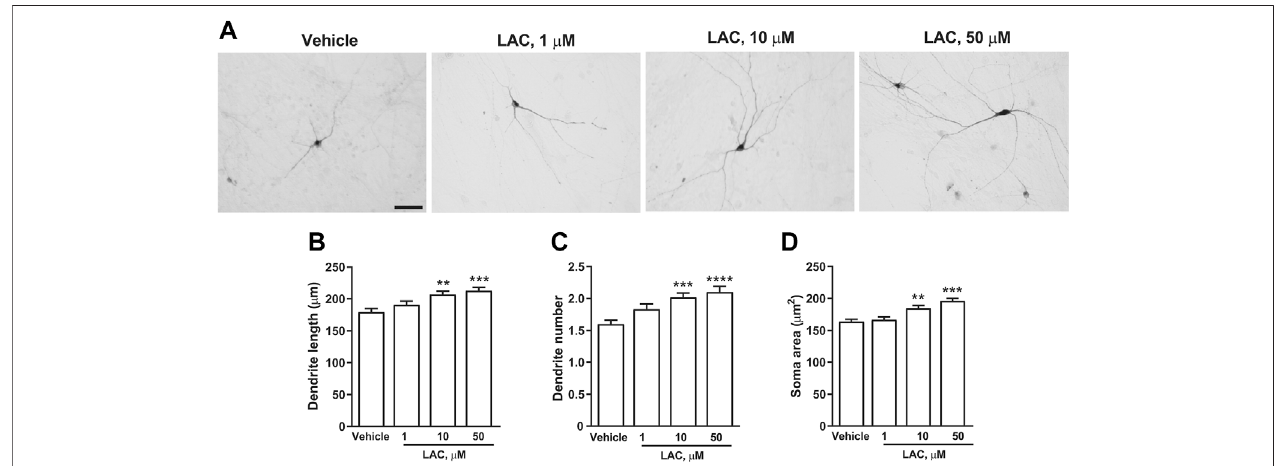
FIGURE 5 | LAC promotes structural plasticity of human iPSC-derived DA neurons. Representative photomicrographs of human F3 DA neurons (40 days in culture) 72 h after exposure to vehicle or LAC (1, 10, 50 μ m) are shown in (A) . Scale bar: 50 μ m. Treatment effect on maximal dendrite length, number of primary dendritesandsomaareaofhumanF3DAneuronsisshownin (B – D) .Valuesaremeans±S.E.M.(**** p < 0.0001;*** p < 0.001;** p < 0.01vs.vehicle;One-wayANOVA+ Fisher ’ s LSD) (B) F (3,396) = 7.674; p < 0.0001 (C) F (3,396) = 8.643; p < 0.0001 (D) F (3,396) = 14.44; p < 0.0001.